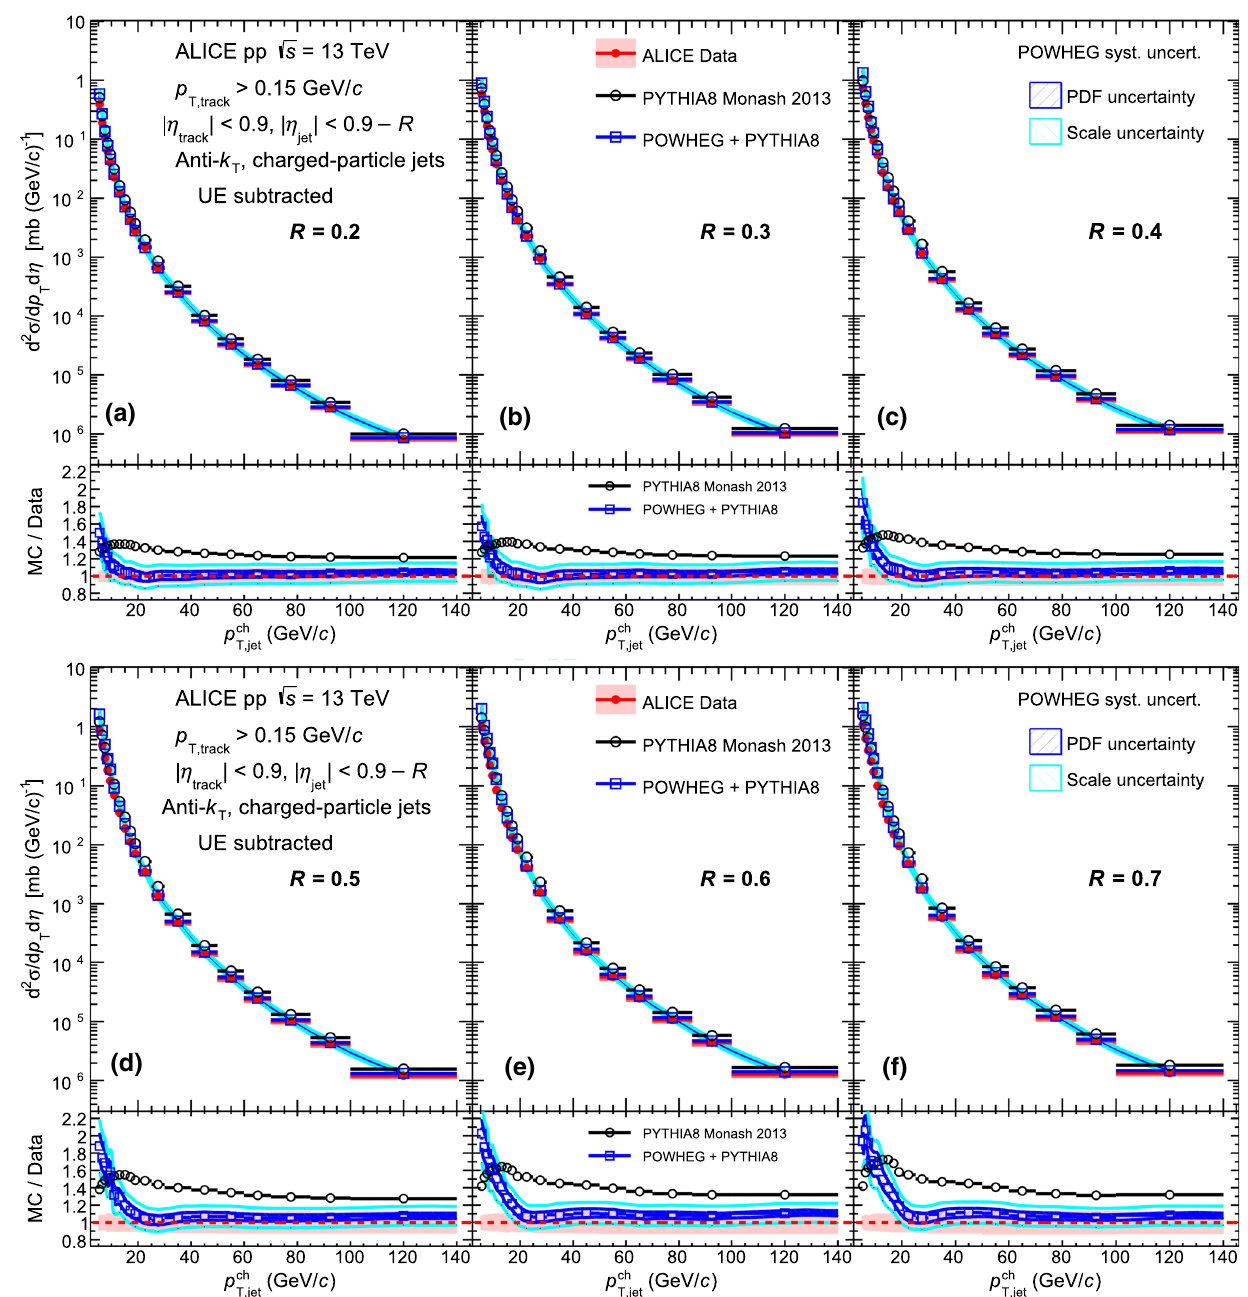
Fig. 4 Inclusive charged-particle jet cross sections in pp collisions at √ s = 13 TeV with UE subtraction. Data for different jet resolution parameters R varied from 0 . 2 to 0 . 7 are compared to LO and NLO MC predictions. The statistical uncertainties are displayed as vertical error